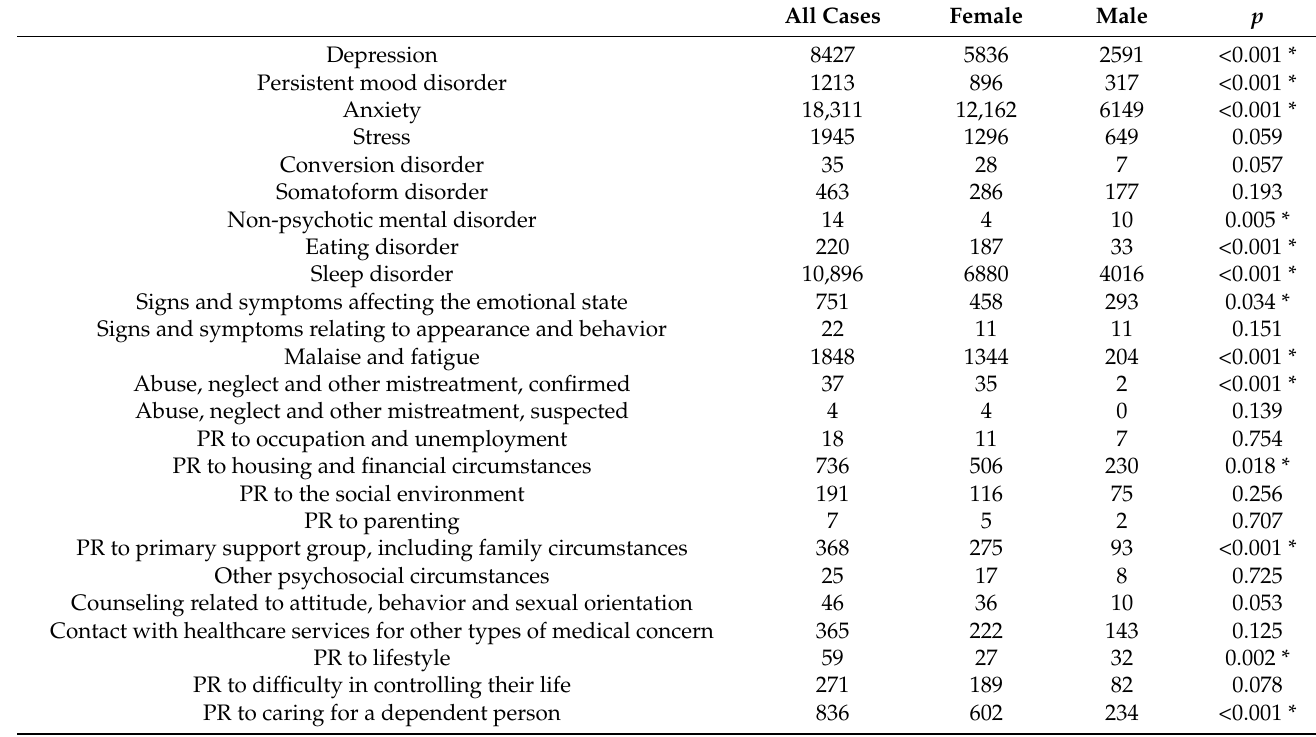
Table 2. Association between diagnostic categories and the sex of the study population.